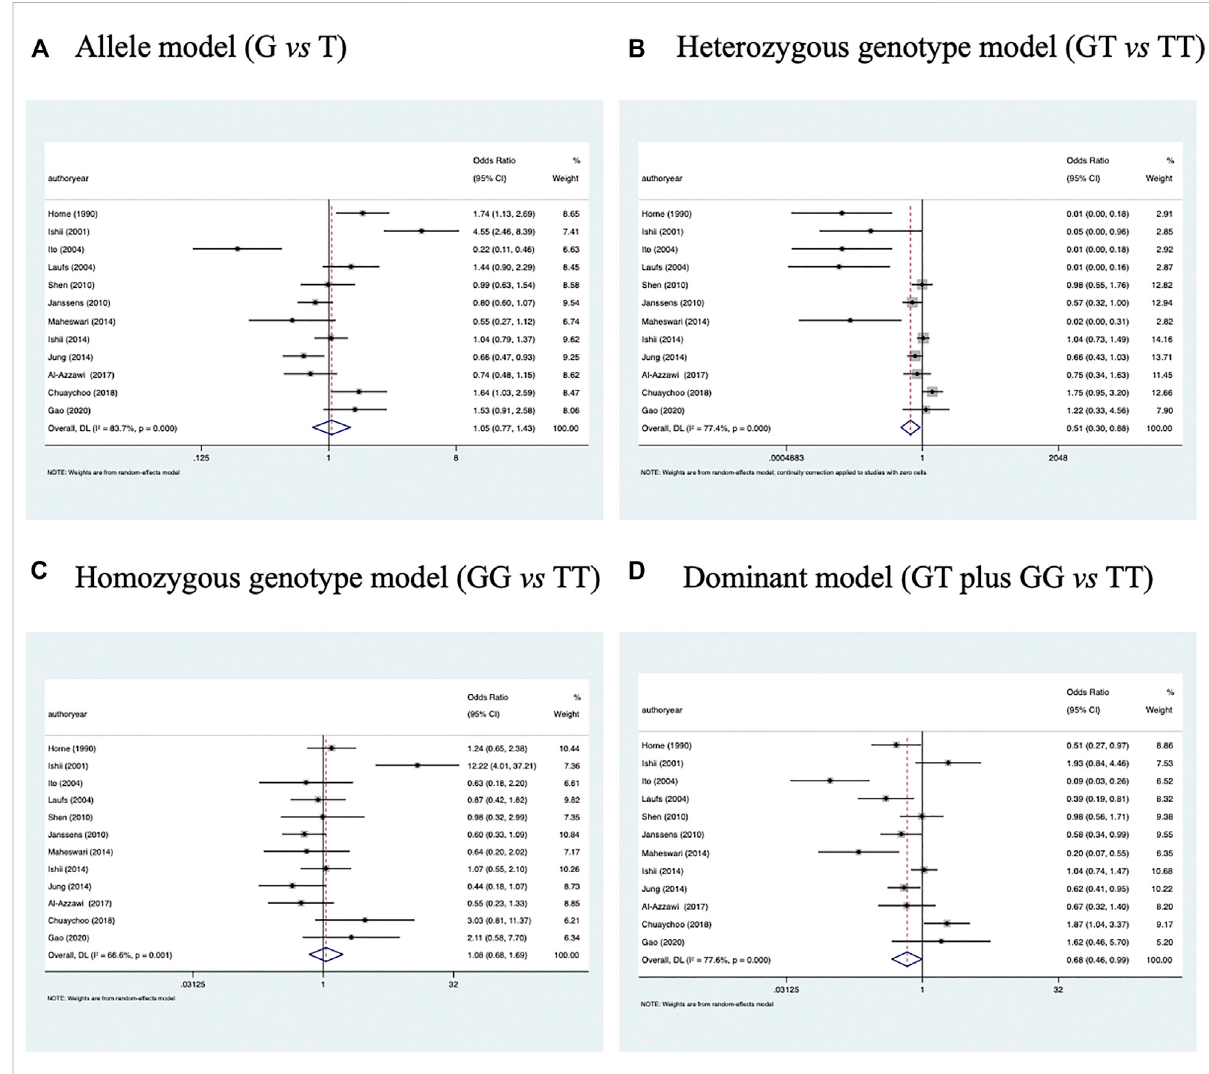
FIGURE 2 Forest plots of VDBP gene rs7041 polymorphism with COPD under four models of inheritance. (A) Allele model (G vs. T), (B) Heterozygous genotype model (GT vs. TT), (C) Homozygous genotype model (GG vs. TT), (D) Dominant model (GT plus GG vs.